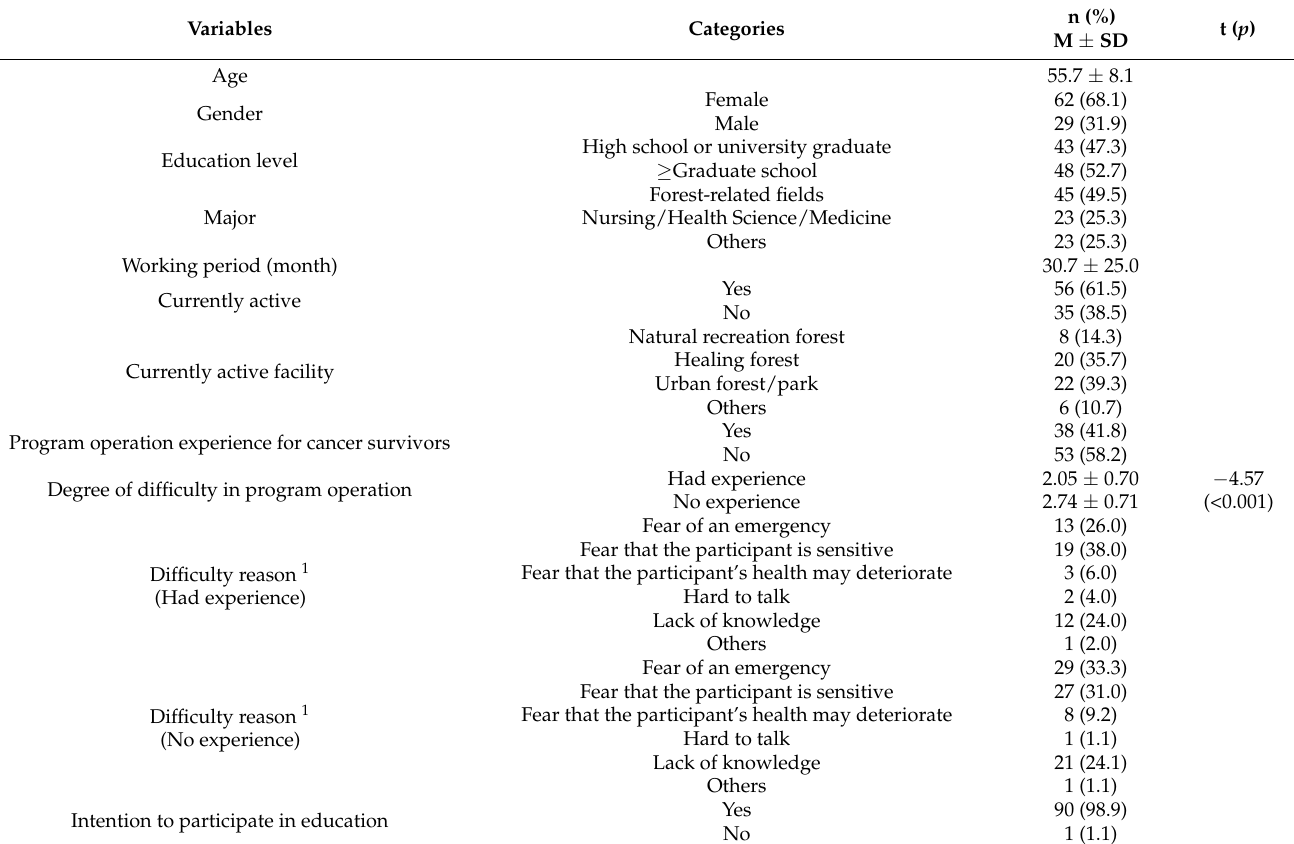
Table 1. Participants’ characteristics and cancer survivor program operation experience.